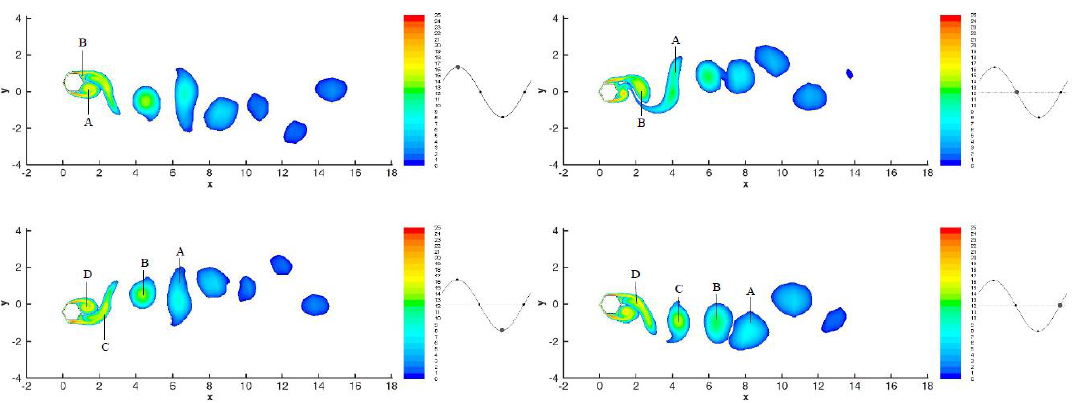
Figure 9. Vorticity contours at four instants in a vibration period of the corner-oriented hexagonal cylinder at Vr = 20.57 at 9.25 < t* < 10.40.